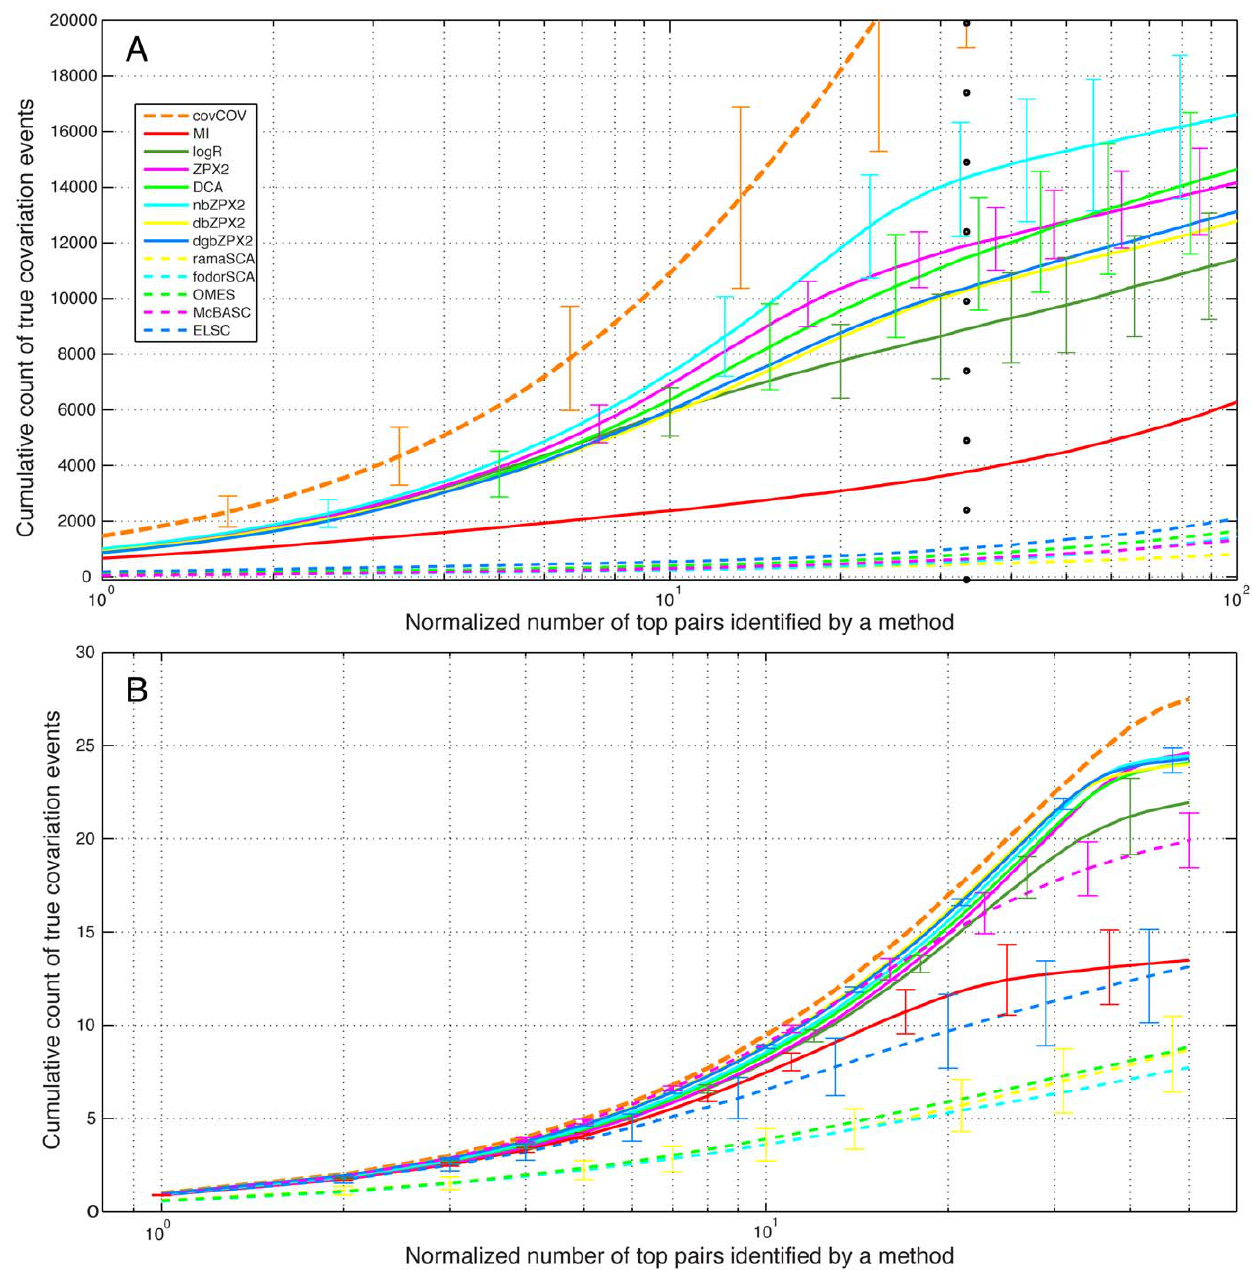
Figure 4. Averaged results for 8 protein families with simulated MSAs under 500 sequences. Cumulative count of covariation events corresponding to the top scoring pairs in the coevolution matrices generated by different methods. A. MSAs simulated with MSAvolve: a dotted vertical line marks the total number of true covarying pairs controlled by the program (as shown in Table 1). B. MSAs simulated with SIMPROT: in these simulations a total number of 50 covarying pairs was used regardless of the sequence length. Since each curve of the two panels is not the average of independent replicas of the same experiment, traditional standard deviation ( std ) has no meaning in this case. The error bars for selected points i represent a weighted std (w s i ) calculated as